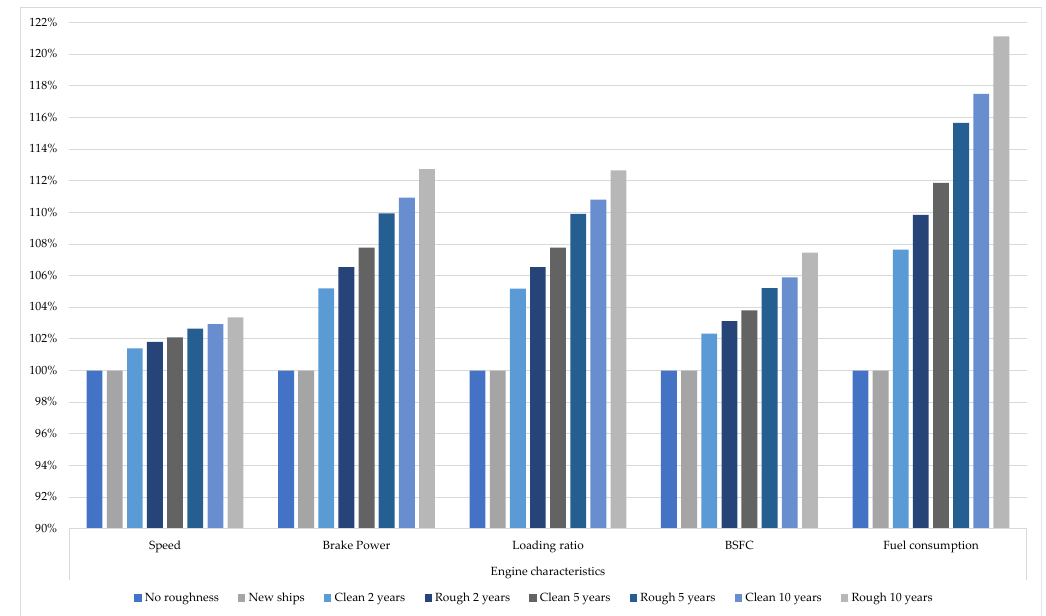
Figure 3. Percentage of changing cavitation and noise criteria for different hull roughness.